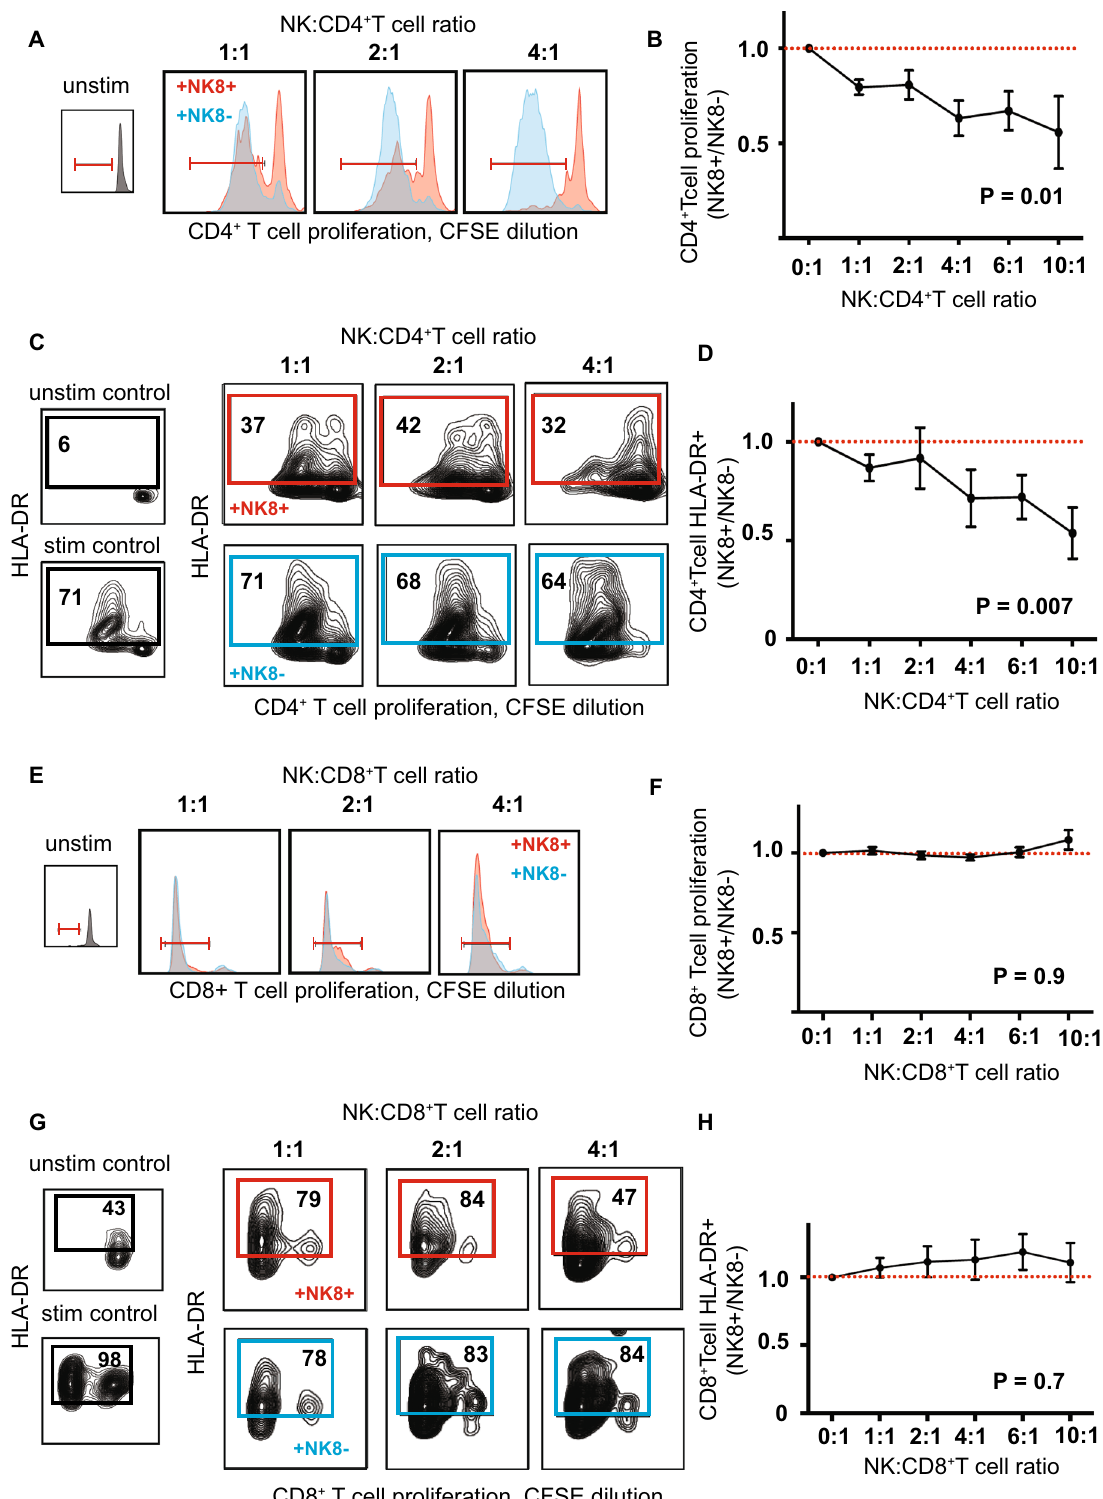
Fig. 2 NK8 cells regulate autologous CD4 + T cell activation. Representative histograms ( A , E ), contour plots ( C , G ) and summary scatter/line plots ( B , D , F , H ) showing fl ow cytometric quanti fi cation of CD4 + ( A – D ) and CD8 + ( E – H ) T cell proliferation ( A , B , E , F , CFSE dilution) and activation (HLADR expression, C , D , G , H ) when unstimulated (inset, black) or following polyclonal stimulation in vitro (anti-CD2/3/28 bead) in the presence of a titrated ratio of autologous NK8 + (red) or NK8 − (blue) cells as indicated. Summary NK8 + results ( B, D , F , H ) expressed as ratio relative to paired NK8 − cell- enriched culture. P = 2-way ANOVA with NK:T ratio as the categorical variable. For b, d, f and h n = 5 independent biological replicates per group. Error bars = mean + / − sem, red dashed line = no difference vs